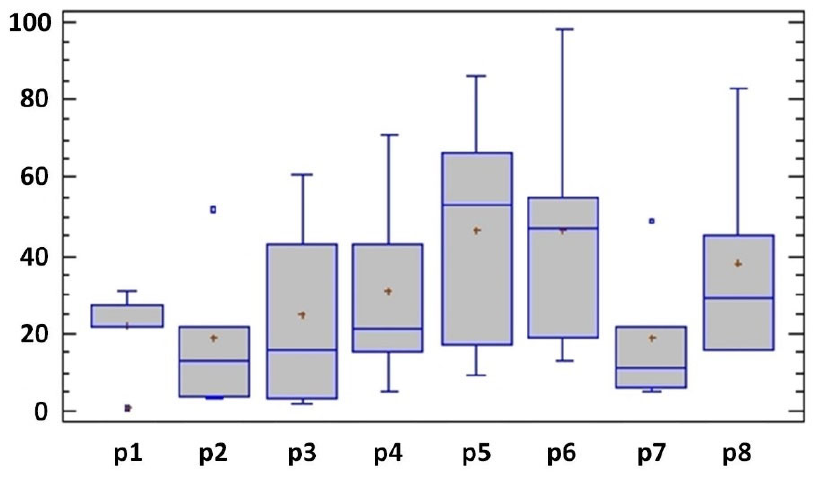
Figure 9. Box plot of 2 series of experiments.